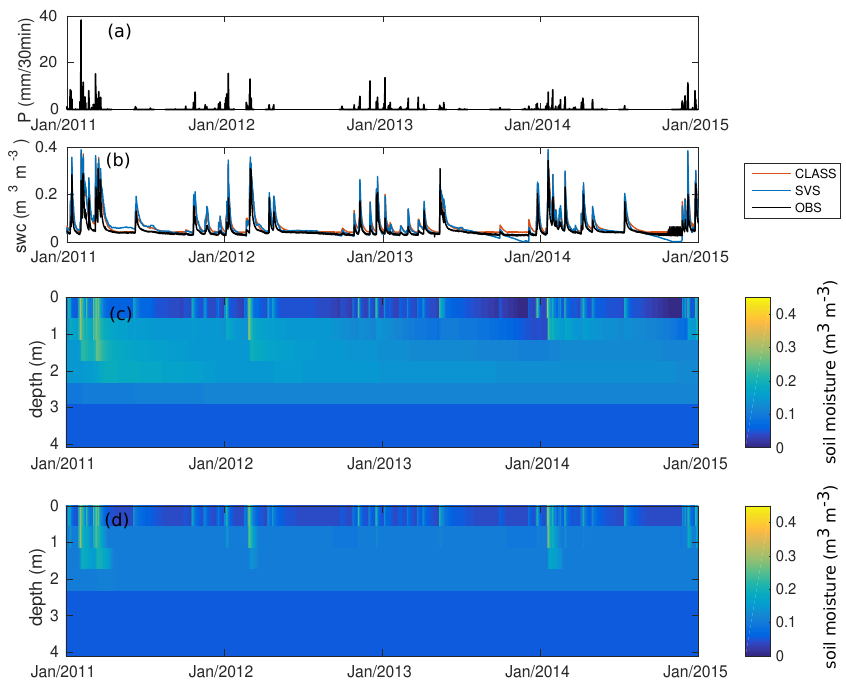
Figure 6. Precipitation (P) and soil water content (SWC) at 30-min time steps for the AU-ASM arid site: ( a ) precipitation; ( b ) soil water content at the surface layer (0–10 cm) for observations (black lines), SVS simulations (blue line) and CLASS simulations (red line); and simulated soil water content profile for the ( c ) SVS and ( d ) CLASS models.